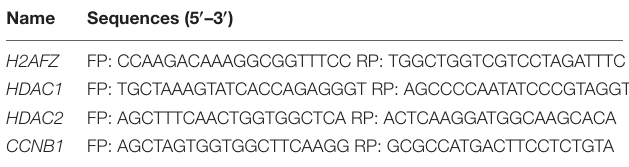
TABLE 1 | PCR primers used in the current